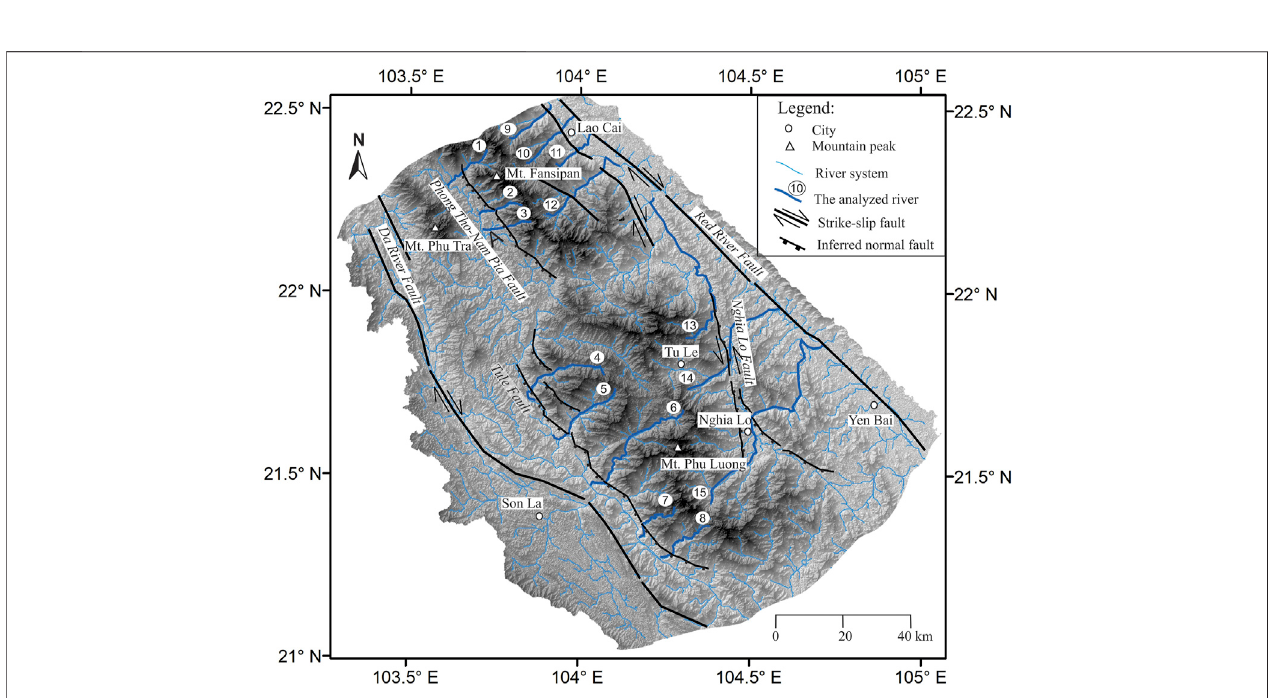
FIGURE 9 | The map showing the stream-length gradient index (SL) values within and surrounding the Fansipan and Tule mountain ranges.